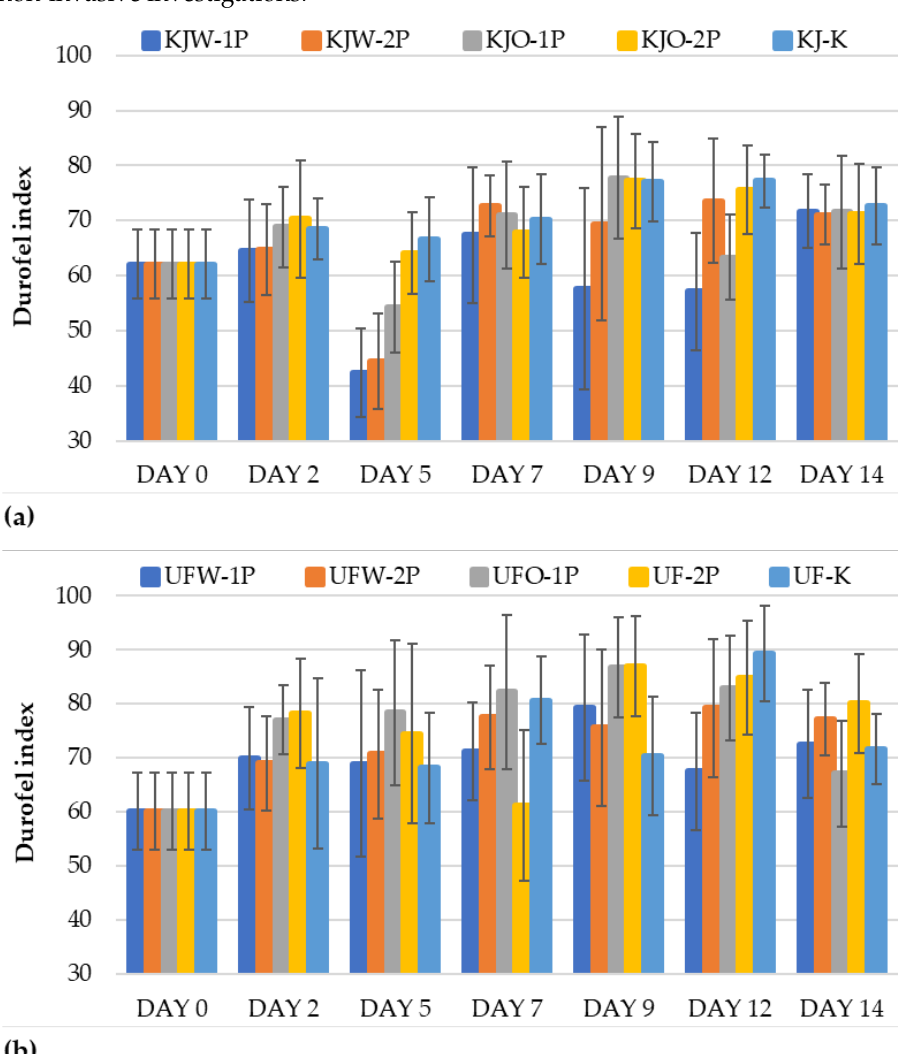
Figure 5. Change in firmness (Durofel Index) during the storage of control and MAP: ( a ) ‘K á ntorj á nosi’ and ( b ) ‘ Ú jfeh é rt ó i fürtös’ sour cherries with different washing pretreatments.